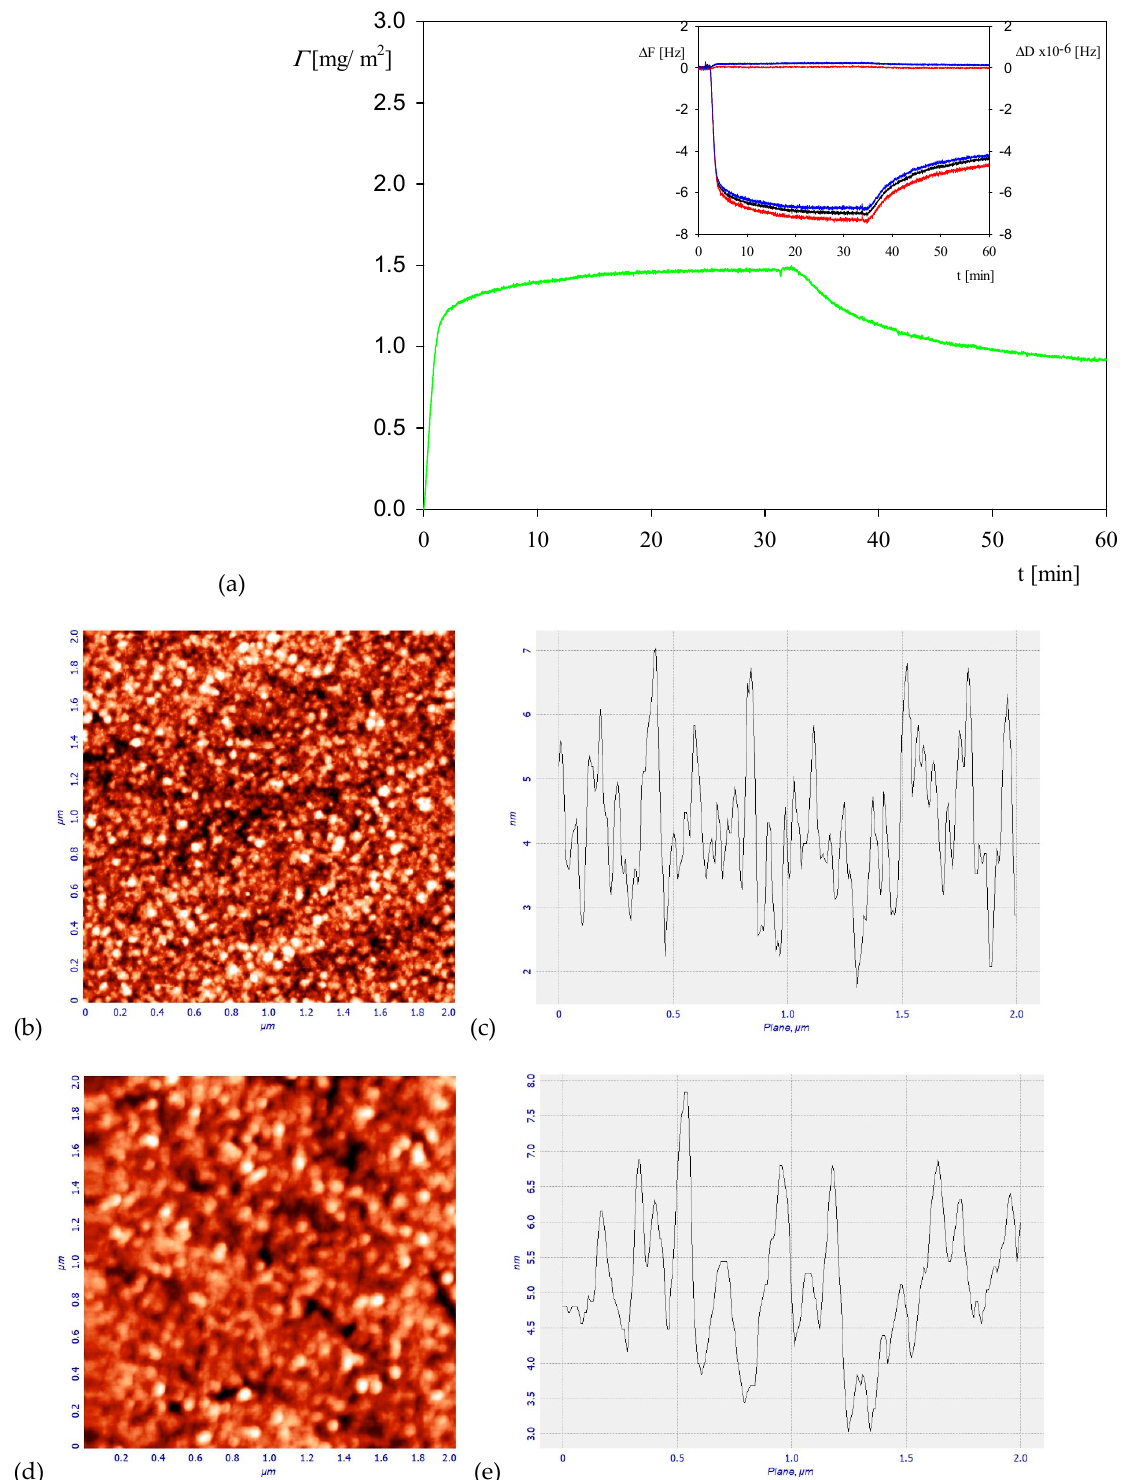
Figure 2. Part ( a ) the kinetics of myoglobin adsorption on silica sensor determined by QCM, flow rate 2.5 × 10 − 3 cm 3 s − 1 , bulk protein concentration equal to 5 mg L − 1 , 0.01 M NaCl, pH 3.5. At the time of 30 min, the rinsing run was initiated by flushing pure electrolytes at the same ionic strength and pH. The inset shows the primary frequency shift Δ Fq (left hand axis) and dissipation Δ D (right hand axis) as a function of time at the following overtones: ● —7th, ● —9th, ● —11th. Part ( b ) the AFM image of the silica sensor with adsorbed myoglobin molecules, part ( c ) the height profile of the protein layer adsorbed at the sensor. Part ( d ) the AFM image of the clean silica sensor, part ( e ) the height profile of the clean silica